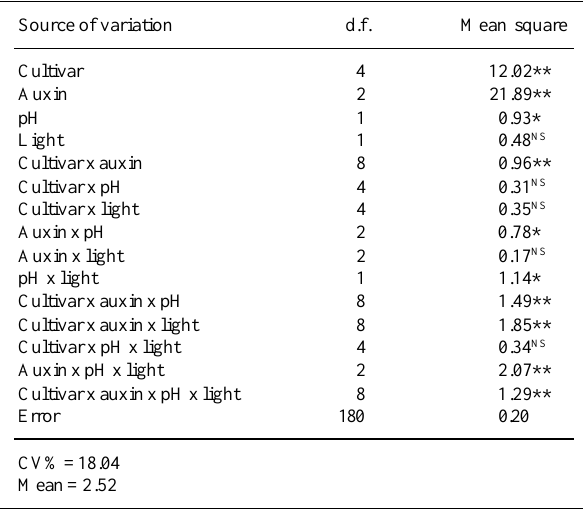
Table I - Variance analysis results of number of somatic embryos in an entirely randomized factorial model.